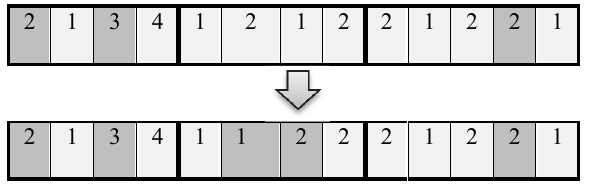
Fig. 7. Discrete crossover to create an infant